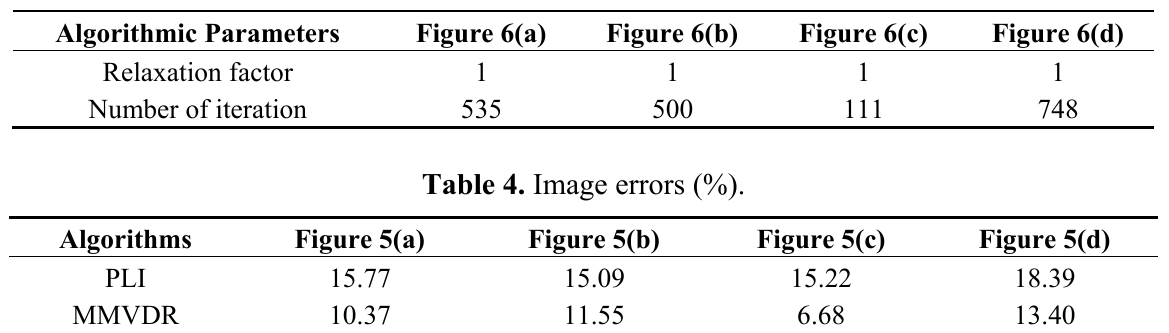
Table 3. Algorithmic parameters for the PLI algorithm.